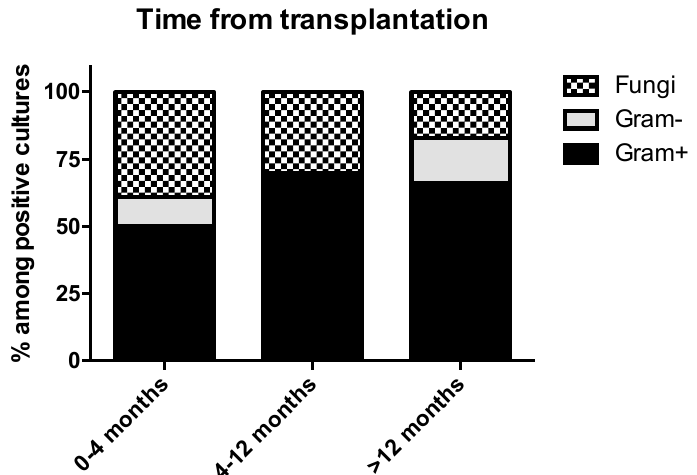
Figure 2. Distribution of pathogens causing Infective Endocarditis with respect to time from liver transplantation. Bars show percentages among 47 patients with available data. Gram-: Gram-negative microorganisms; Gram+: Gram-positive microorganisms.